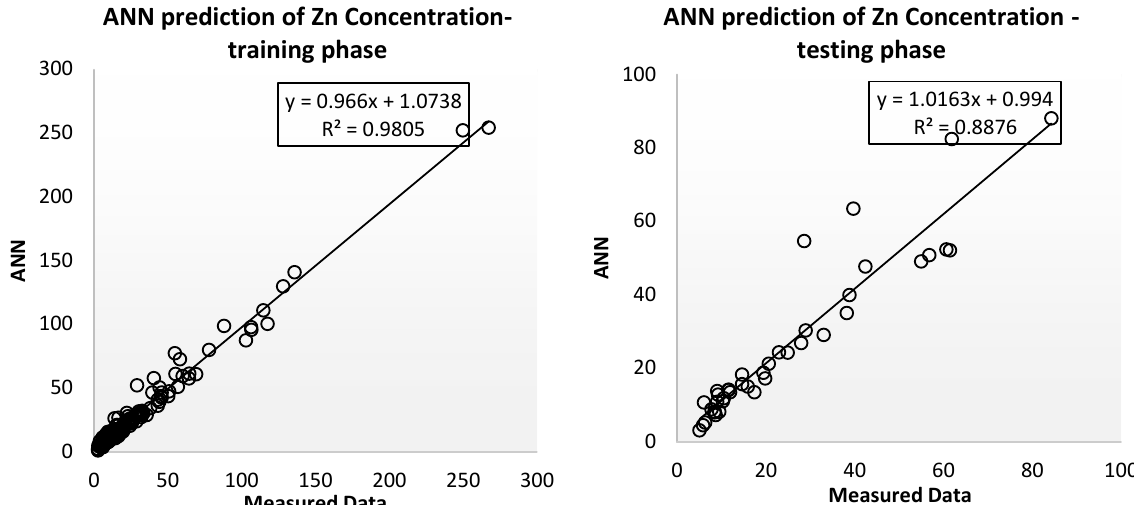
Figure 8. Scattered plot of predicted with actual values for Zn in training (left) and testing (right) phases ANN: Artificial neural